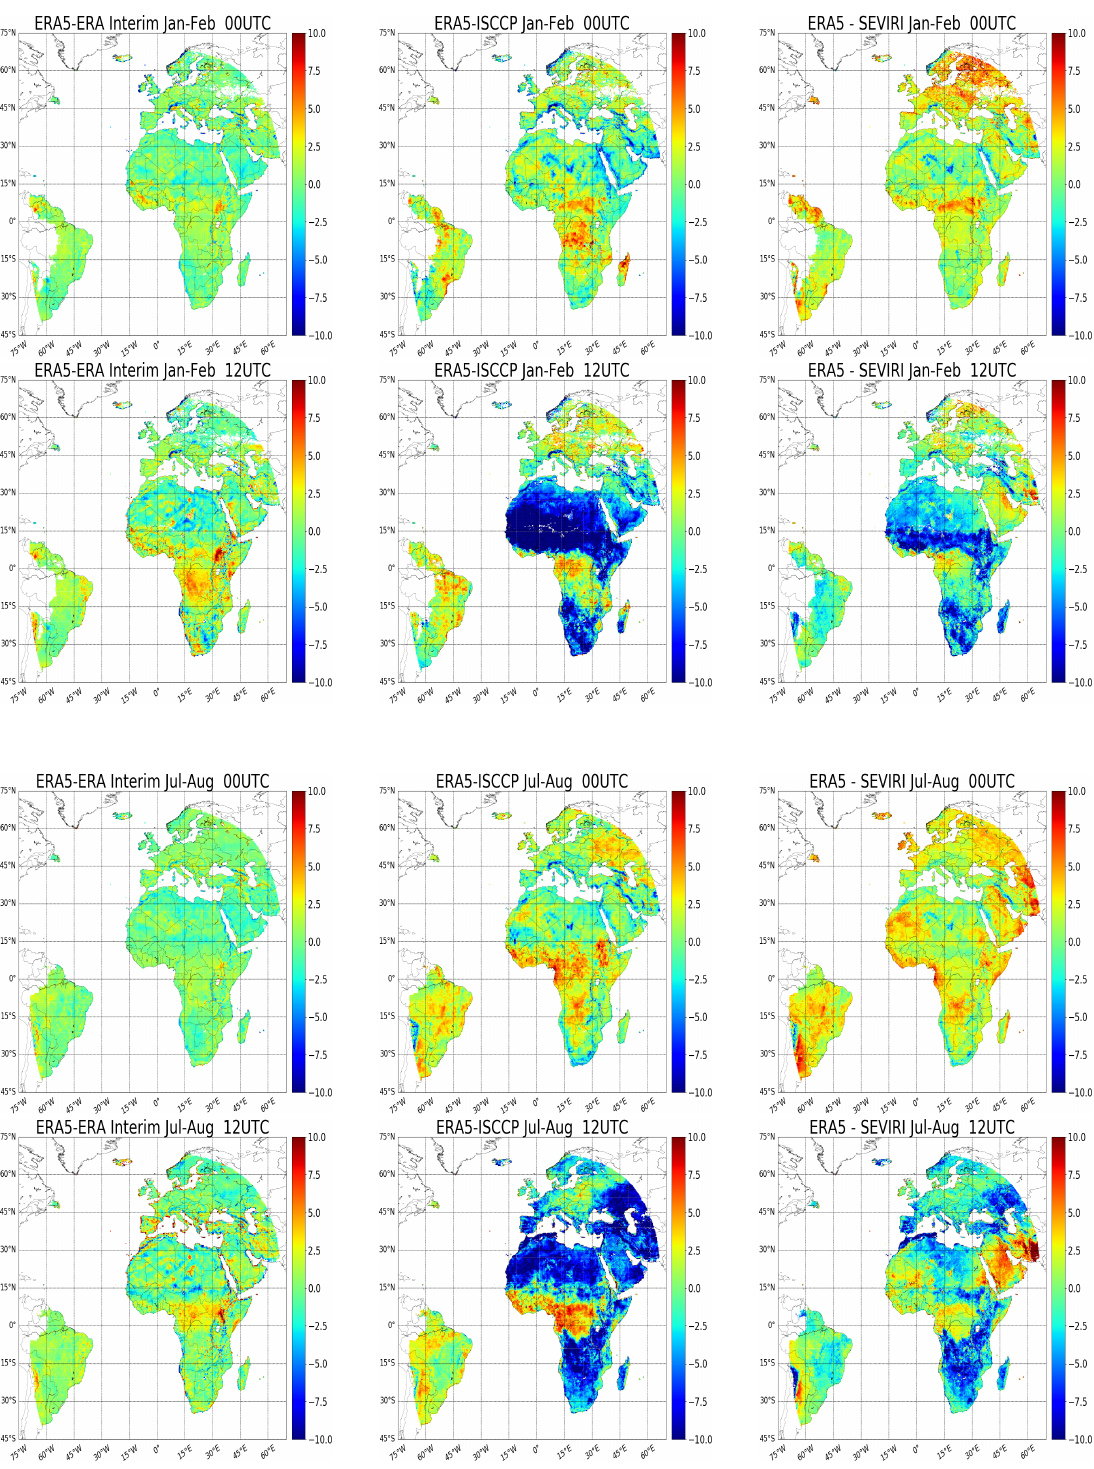
Figure 1. Monthly mean differences of LST (unit: K) for ERA5-ERA Interim, ERA5-ISCCP, and ERA5-SEVIRI at 00 UTC and 12 UTC of two seasons, i.e., January–February, July–August in 2010. The first two rows shows the results in January–February, with 00 UTC at top and then 12 UTC below. The last two rows show the results at the same UTCs in July–August. There are three columns, the left one shows ERA5-ERA Interim, the middle one ERA5-ISCCP, and the right one